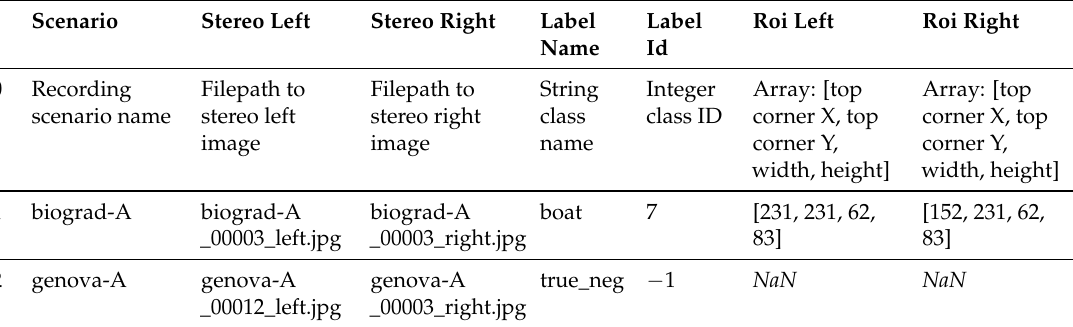
Table 3. Header from underwater gestures database *.csv file. Row 0 describes the data fields, Row 1 and Row 2 have an example of a true positive and a true negative sample respectively. Scenario Stereo Left Stereo Right Label Roi Left Roi Right Name